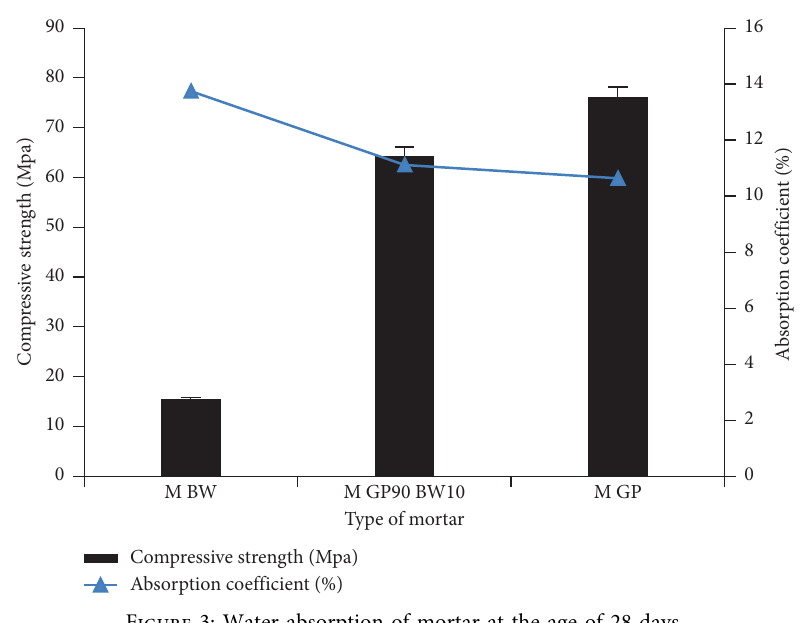
Figure 3: Water absorption of mortar at the age of 28 days.